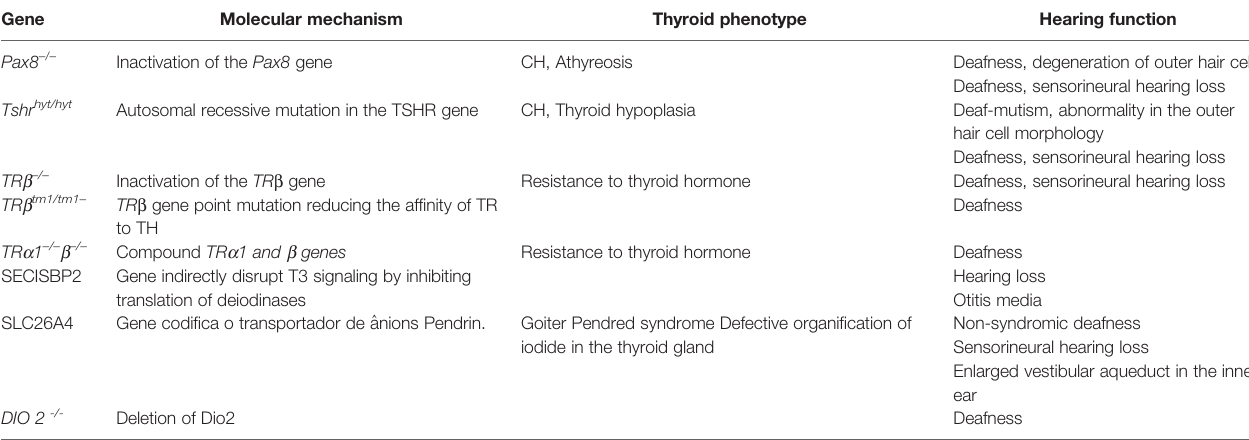
TABLE 1 | Mouse models for understanding the relevance of genes involved in thyroid development, hormone biosynthesis, and thyroid hormone action on hearing